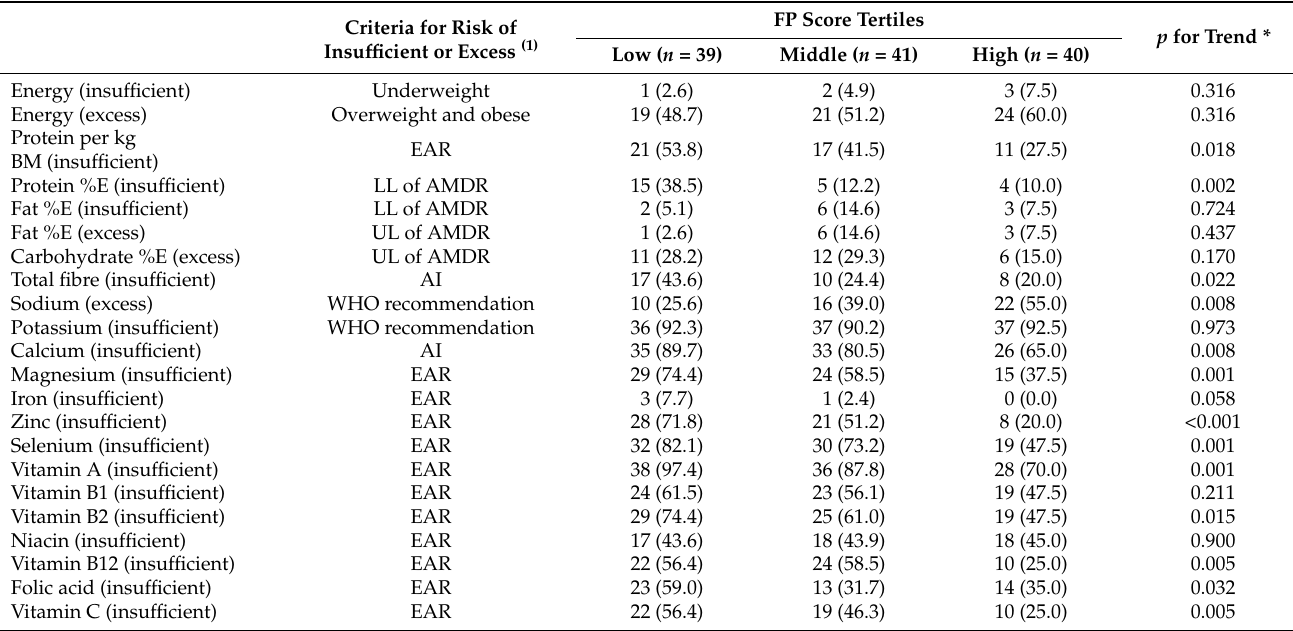
Table 5. The risk rate of insufficient or excess nutrient intake by the FP score tertiles. Criteria for Risk of Insufficient or Excess